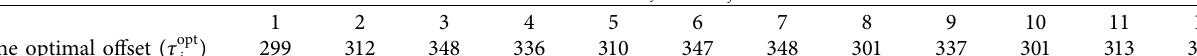
( n 1 ). 1 W fra j of j ( n j + τ j ).